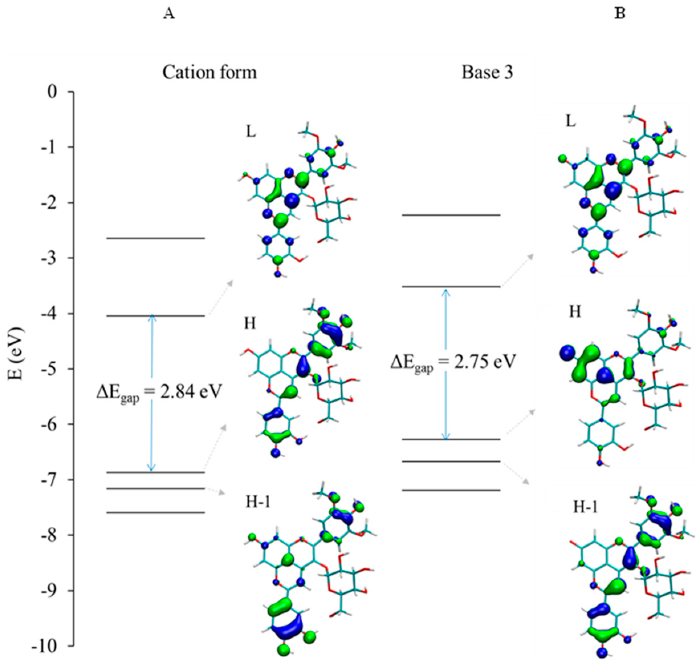
Figure 4. Molecular orbitals (MO) correlation diagram of PA1 for: ( A ) AH + ; and ( B ) the A-form resulting from deprotonation of C7A-OH (base 3).